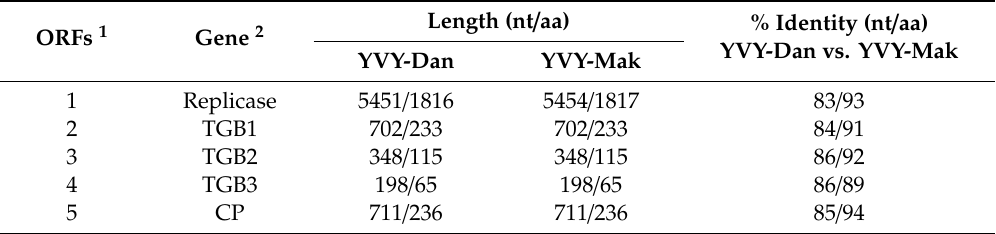
Table 1. Nucleotide and amino acid length of putative genes and identity percentages (%) between the YVY-Dan and YVY-Mak isolates described in this